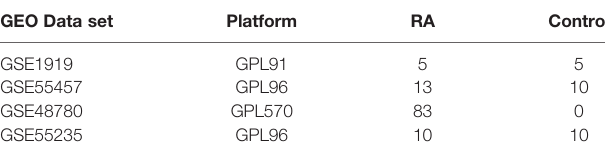
TABLE 1 | Information on microarray datasets obtained from Gene Expression Omnibus. GEO Data set